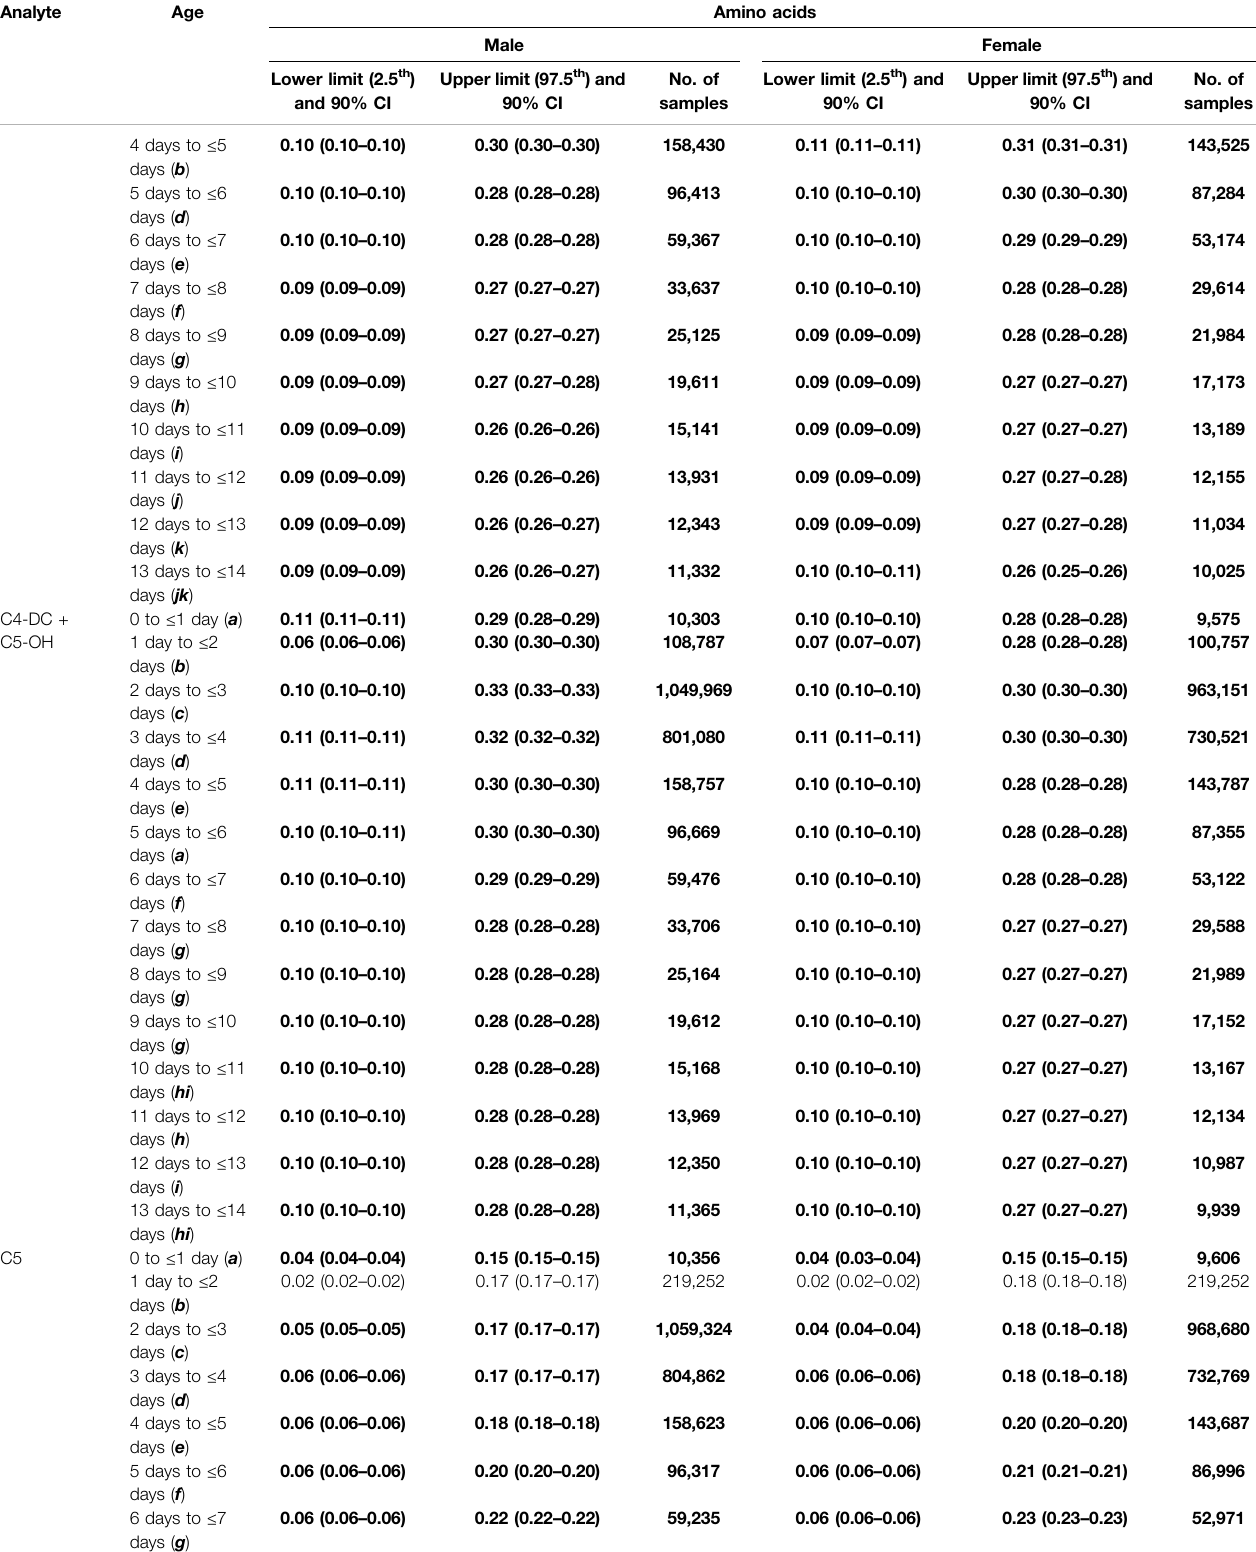
TABLE 2 | ( Continued ) The Reference intervals partitioned by each day and sex for 35 MS/MS NBS biomarkers ( μ